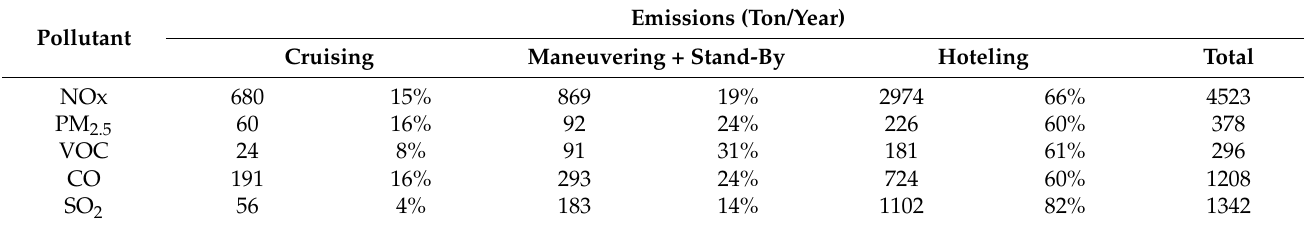
Table A21. Total emissions from vessels (Ashdod, MPS A2 2025).